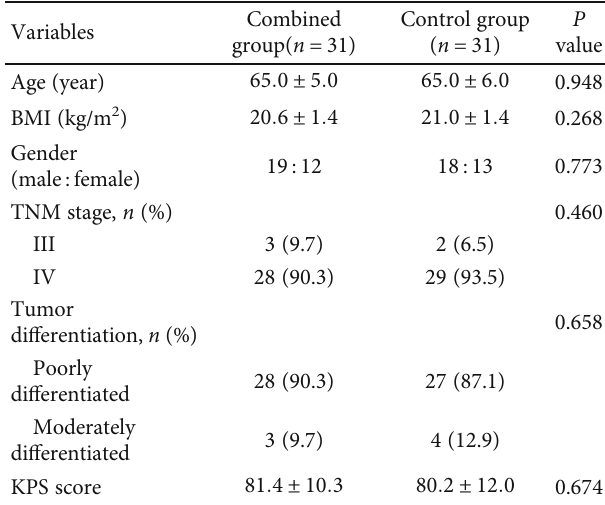
Table 1: Patients ’